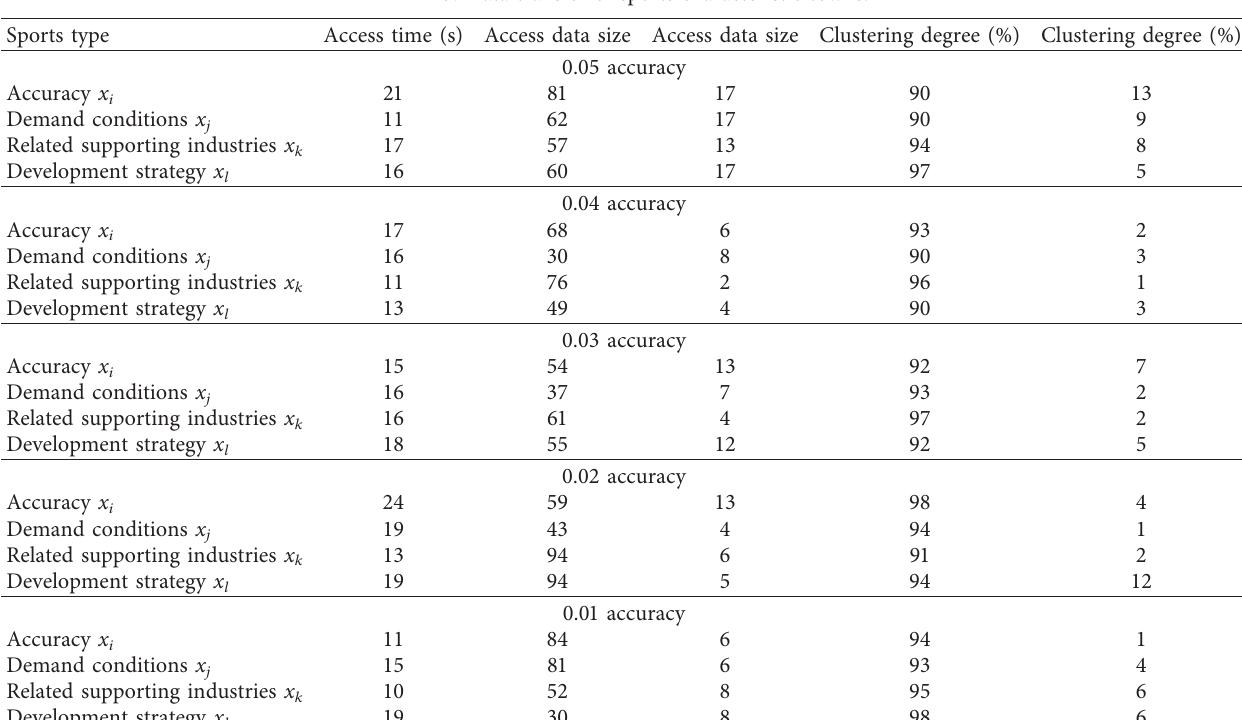
Table 3: Data transfer of sports characteristic